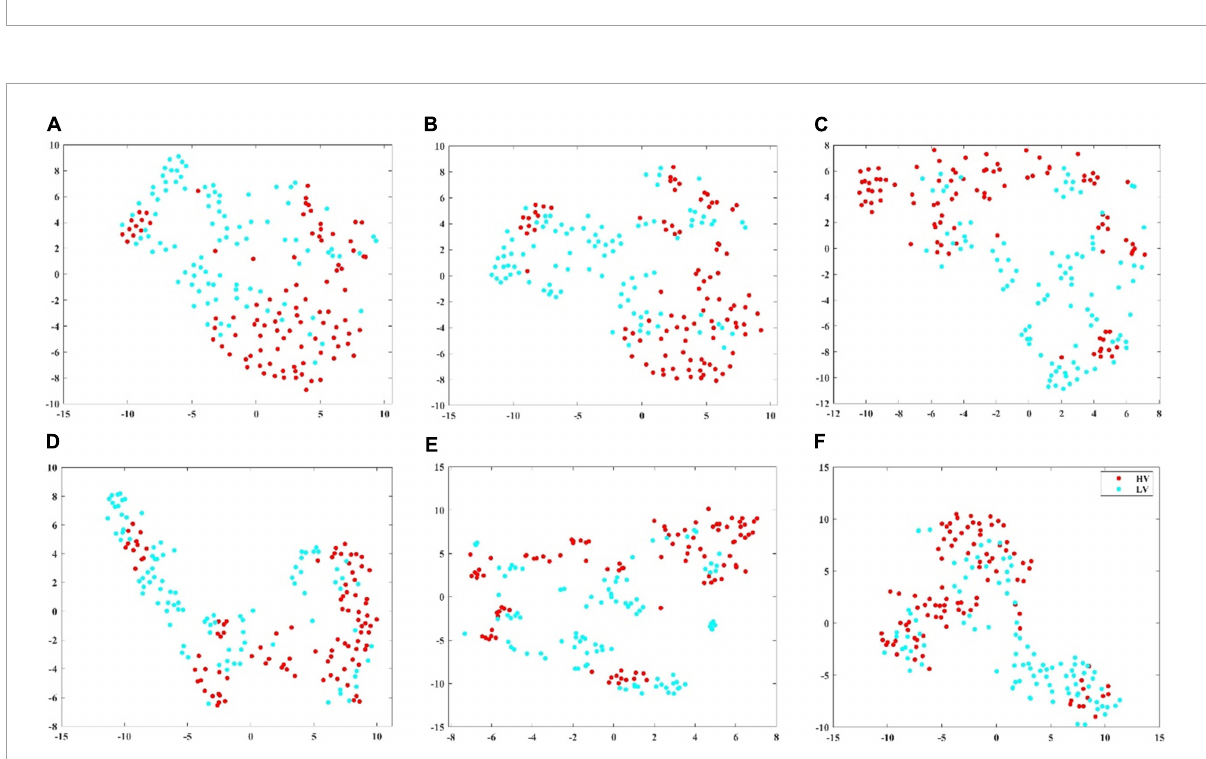
FIGURE4 Feature visualization map on ESD dataset. (A) Second-order difference; (B) first-order difference; (C) fractal dimension; (D) high gamma band power; (E) high gamma band differential entropy; (F) high gamma band CPL of coherence network.